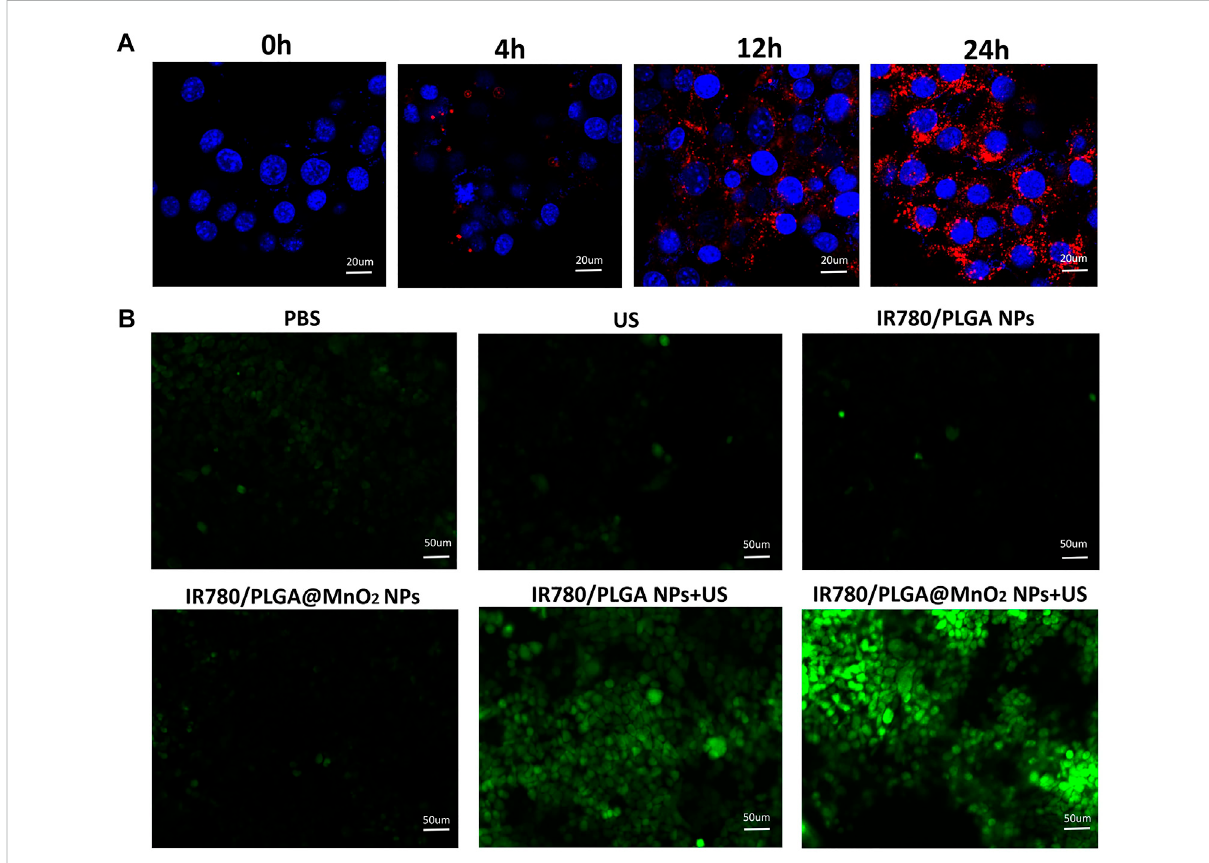
FIGURE 4 (A) Fluorescence images of 4T1 cells incubated with IR780/PLGA@MnO 2 NPs for 0, 4, 12 and 24 h (scale bar: 20 μ m). (B) Fluorescence microscope images of DCFH-DA stained 4T1 cells subjected to different treatments: (Hussain and Nguyen, 2014) PBS, (Wells, 2006) US, (Wu et al., 2005) IR780/PLGA NPs, (Ahmadi et al., 2020) IR780/PLGA@MnO 2 NPs, (Qian et al., 2016) IR780/PLGA NPs + US, (Wood and Sehgal, 2015) IR780/